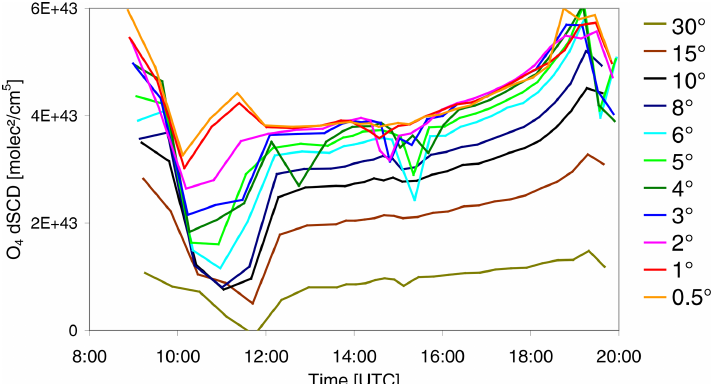
Figure A4. Time series of the retrieved O 4 dSCD on 2 May 2019 for the different elevation angles. During the afternoon, for most of the time, smooth variations are found. However, for some times and elevation angles, systematic deviations of the O 4 dSCDs occur, which are caused by scattered